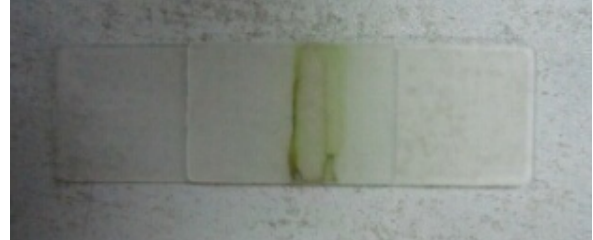
Figure 12. The welding of TGMPP and